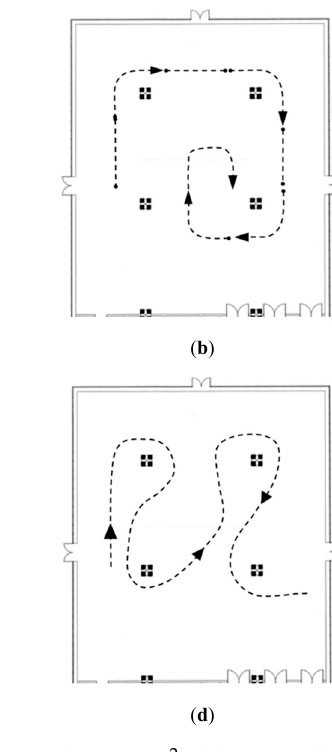
Figure 4. Paths traveled by the athlete in a rectangular room (20 × 17 m 2 ): ( a ) square, ( b ) spiral, and ( c , d ) complex paths [33].